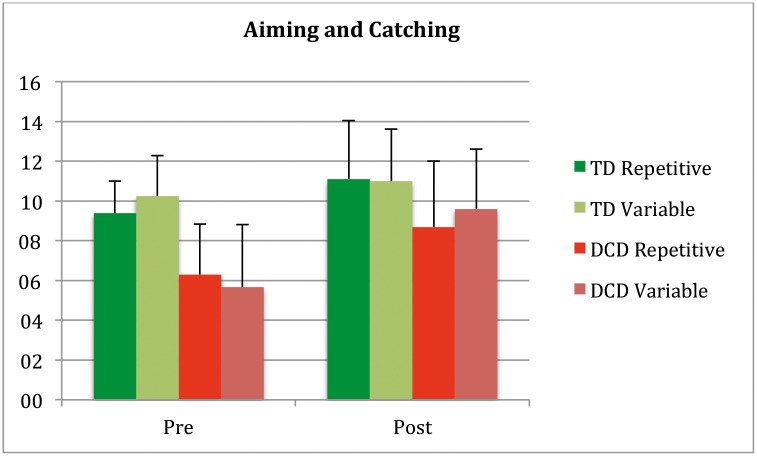
MABC aiming and catching pre and post.